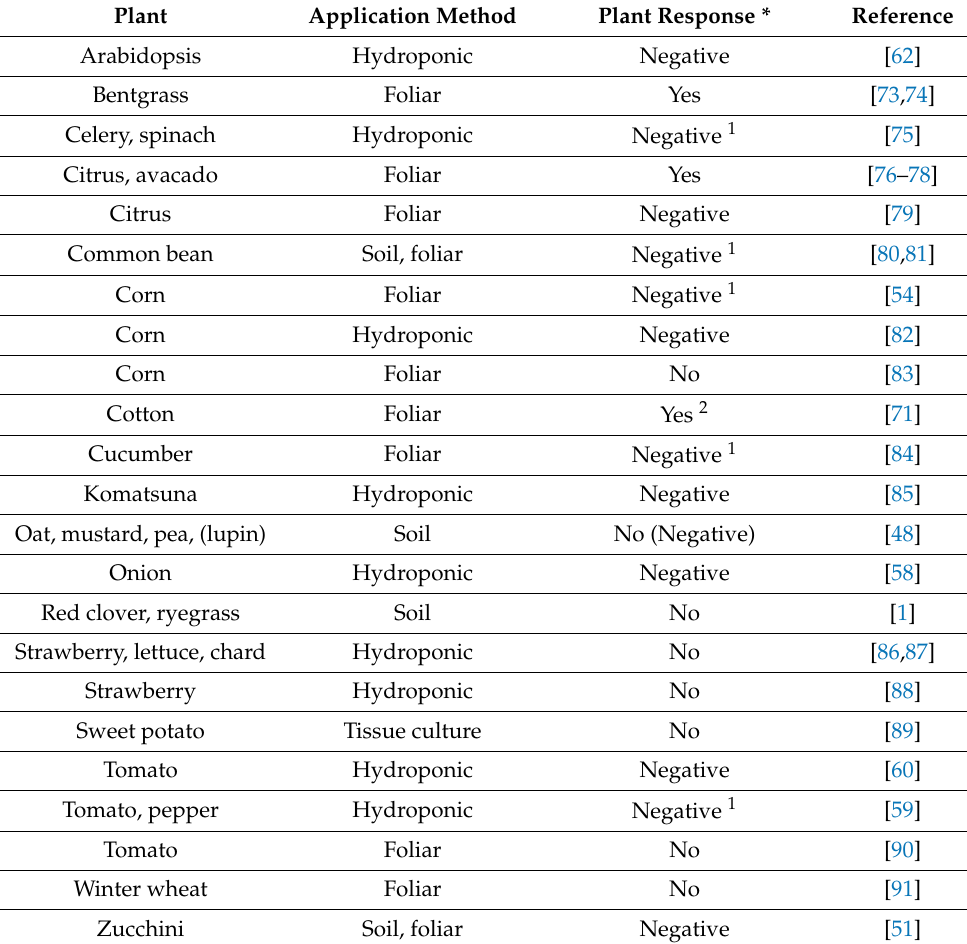
Table 2. Summary of reported Phi use as a P